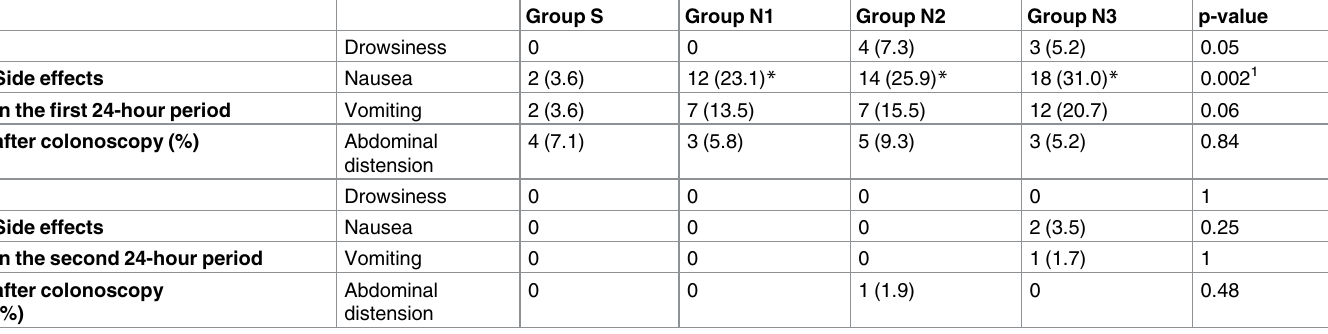
Table 6. Side effectsin the first and second 24-hour periods after